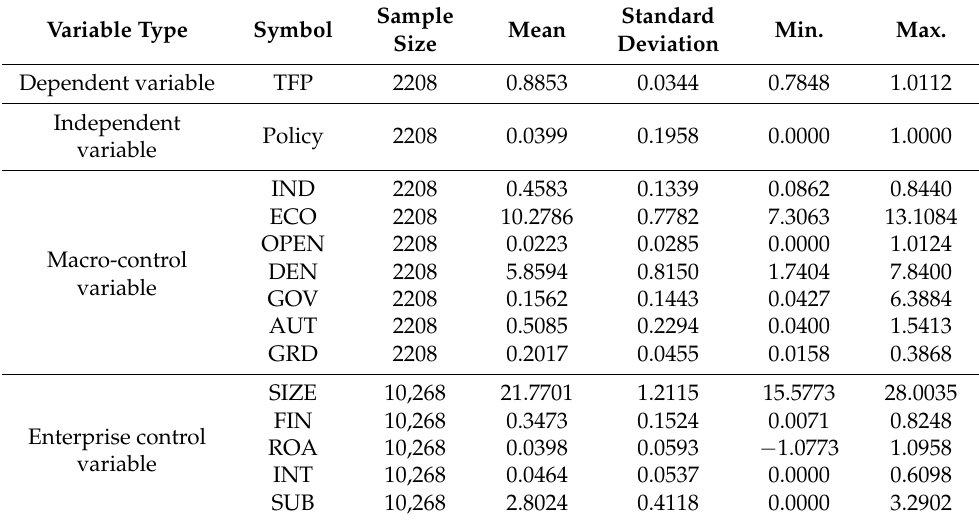
Table 2. Descriptive